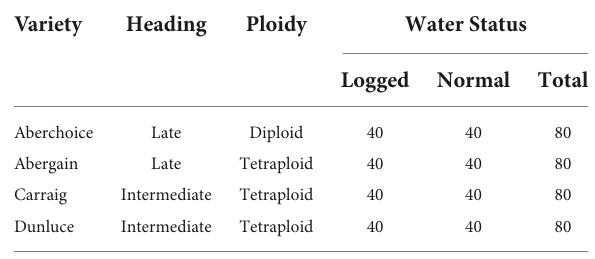
TABLE 2 Perennial ryegrass ( Lolium perenne ) varieties grown and water status for all chambers and variety